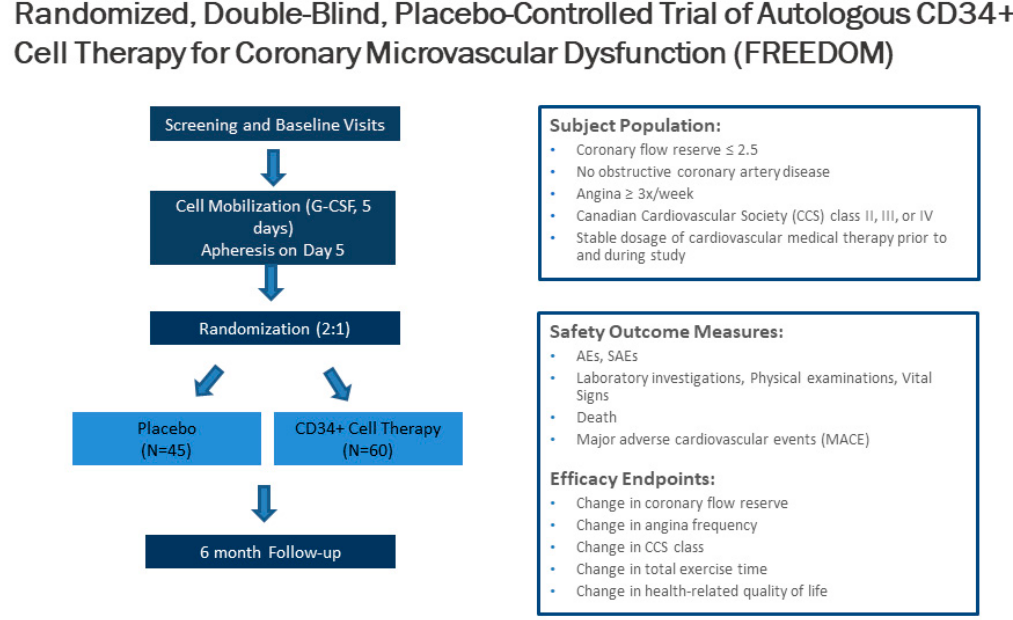
Figure 4. Trial design of the CD34 + cell therapy FREEDOM trial. The FREEDOM trial (NCT04614467) is a randomized, double-blinded, placebo-controlled trial of CD34 + cell therapy for patients with coronary microvascular dysfunction and refractory angina with no obstructive coronary artery disease.